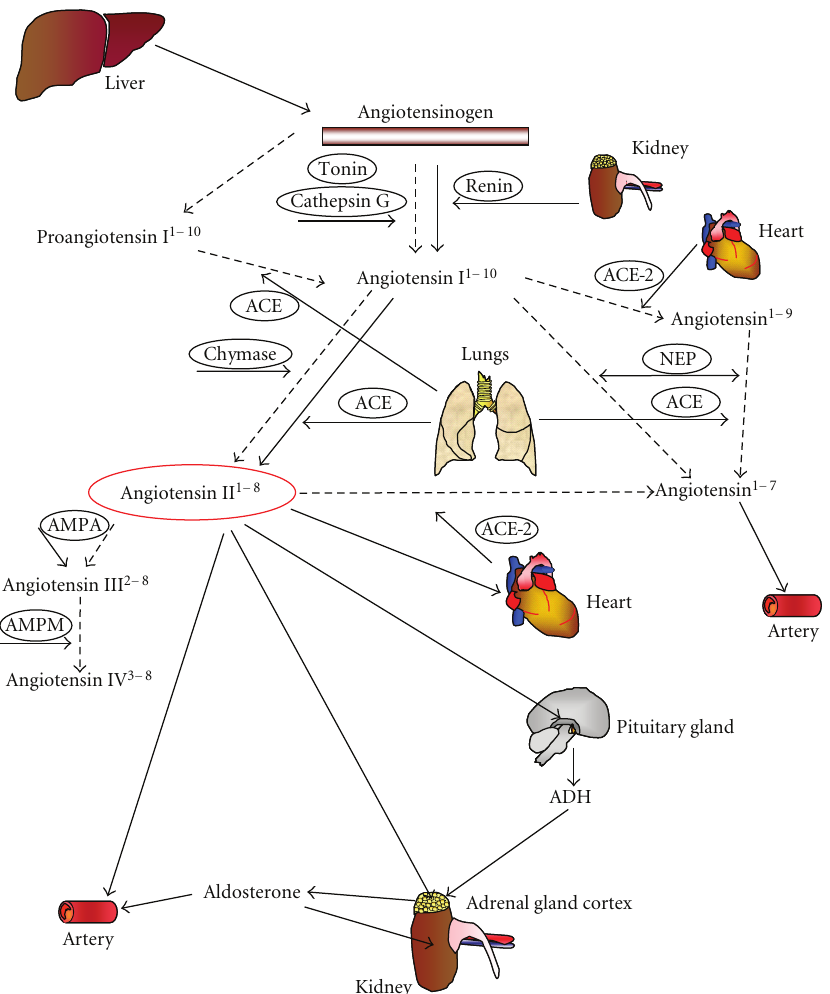
Figure 1: Expanded renin-angiotensin-aldosteron system. Recently, the identification of new angiotensins with di ff erent activities increased the complexity of this hormonal axis. In addition to the crucial activities of the liver, kidney, lung, adrenal gland cortex, and pituitary gland, the heart also influences this system. ACE: angiotensin converting enzyme; ACE-2: angiotensin converting enzyme 2; NEP: neutral endopaptidase; AMPA: aminopeptidase A; AMPM: aminopaptidase